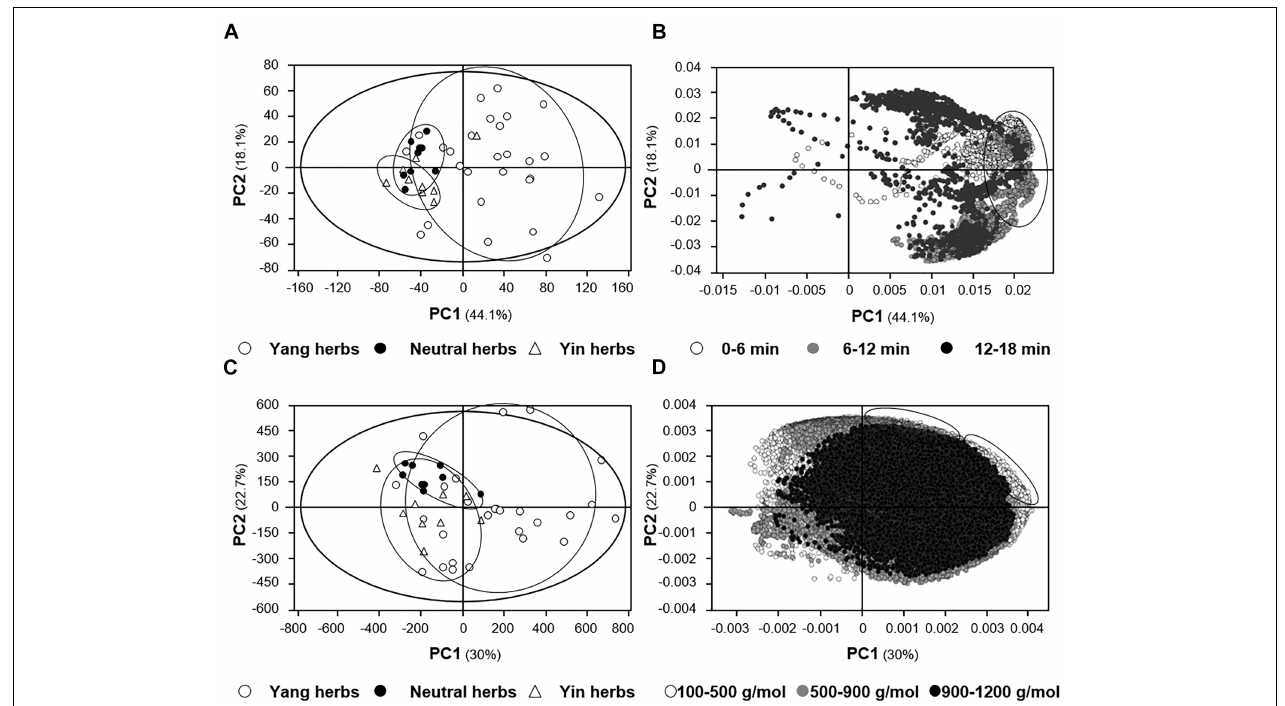
FIGURE 8 | PCA analyses of LC-MS profiles of signals from the 15 spleen-meridian herbs. (A) Scoring plots of TIC. (B) Loading scatter plots of TIC. (C) Scoring plots of spectrum. (D) Loading scatter plots of spectrum. The distribution of each herbal extract in score scatter plots was calculated according to its correlation with the major components. The classification of herbal extracts was according to the “Yin-Yang” nature of herbs, i.e., Yin, neutral and Yang herbs, according to TCM practice. The results showed very obvious discrimination between herbal extracts with different properties. Each dot in the loading scatter plots represents a variable. Dots in (B) represent time intervals for 0.1 s, and dots in (D) represent mass intervals of 0.005 Da.